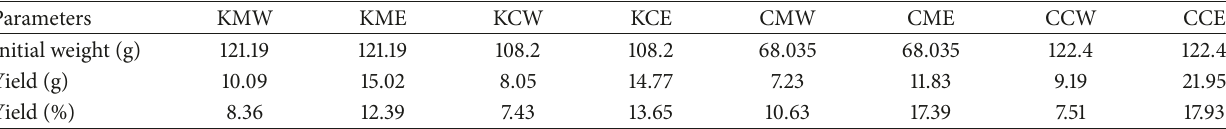
Table 2: The yield of different extracts.